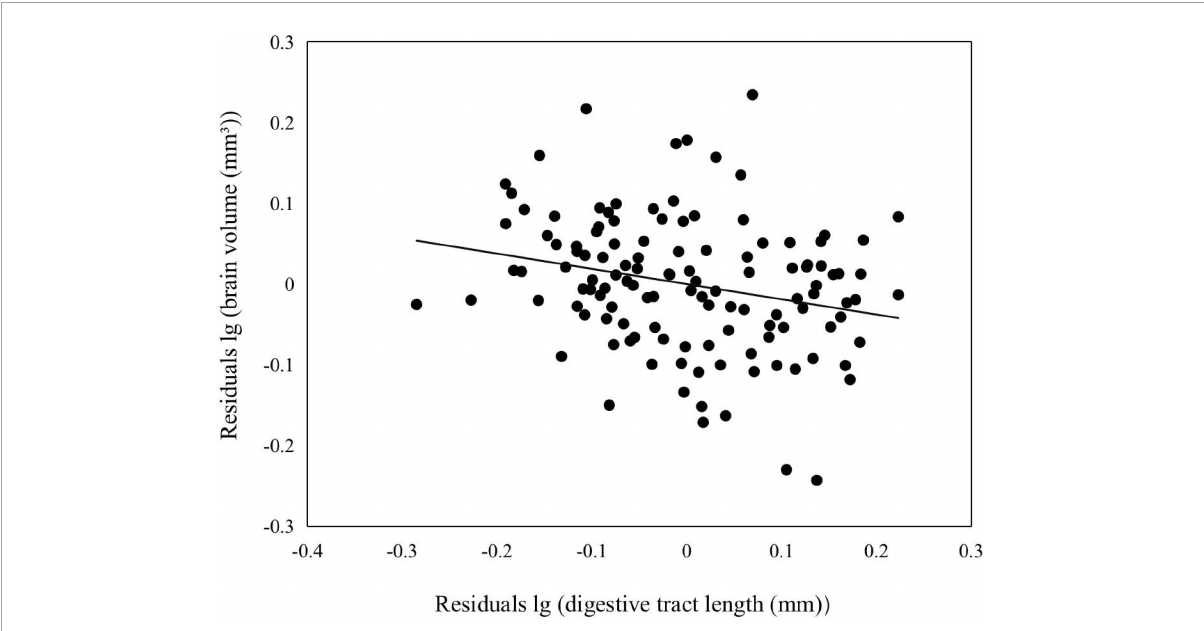
FIGURE3 Correlations between relative brain volume and relative digestive tract length in Feirana quadranus .